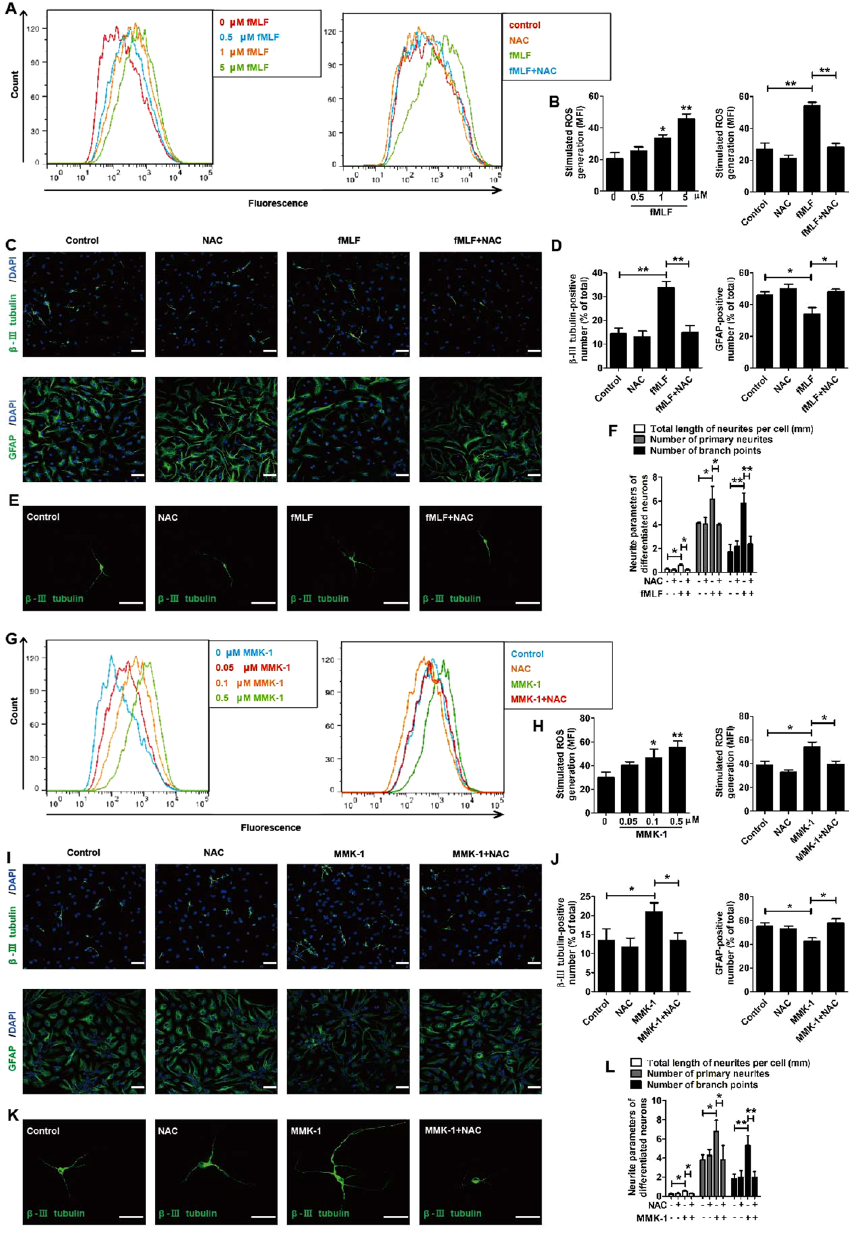
Figure 7. FPRs-induced neuronal differentiation of NSCs was mediated by ROS generation. ( A–F ) FPR1- induced neuronal differentiation of NSCs was mediated by ROS generation. ( A,B ) Flow cytometric analysis for generation of ROS by NSCs incubated in 0, 0.5, 1, and 5 µ M fMLF for 6 h with or without preadministering NAC at 5 mM. ( A ) Representative plots of FPR1-mediated ROS generation. ( B ) Histograms for quantification of ROS generation. The levels of ROS were represented by the median fluorescence intensity. ( C,D ) Dissociated NSCs were differentiated with or without preadministering NAC for 30 min before administering fMLF. The images in ( C ) are representative of several independent experiments, and the graph in ( D ) shows the statistical results. ( E ) Dissociated NSCs were differentiated in an extremely low density (1000 cells/mL), and then the cells were immunostained with β -III tubulin. ( F ) Quantified analysis of the total length of neurites per cell, the number of primary neurites, and the number of branch points. ( G–L ) FPR2-induced neuronal differentiation of NSCs was mediated by ROS generation. ( G,H ) Flow cytometric analysis for generation of ROS by NSCs incubated in 0, 0.05, 0.1, and 0.5 µ M MMK-1 for 6 h with or without preadministering NAC at 5 mM. ( G ) Representative plots of FPR1-mediated ROS generation. ( H ) Histograms for quantification of ROS generation. ( I,J ) Dissociated NSCs were differentiated with or without preadministering NAC for 30 min before administering MMK-1. The images in ( I ) are representative of several independent experiments, and the graph in ( J ) shows the statistical results. ( K ) Representative micrographs of the differentiated cells immunostained with β -III tubulin. ( L ) Quantified analysis of the total length of neurites per cell, the number of primary neurites, and the number of branch points. Data were presented as mean ± SEM; * P < 0.05; ** P < 0.01; N = 4. Scale bar = 20 µ